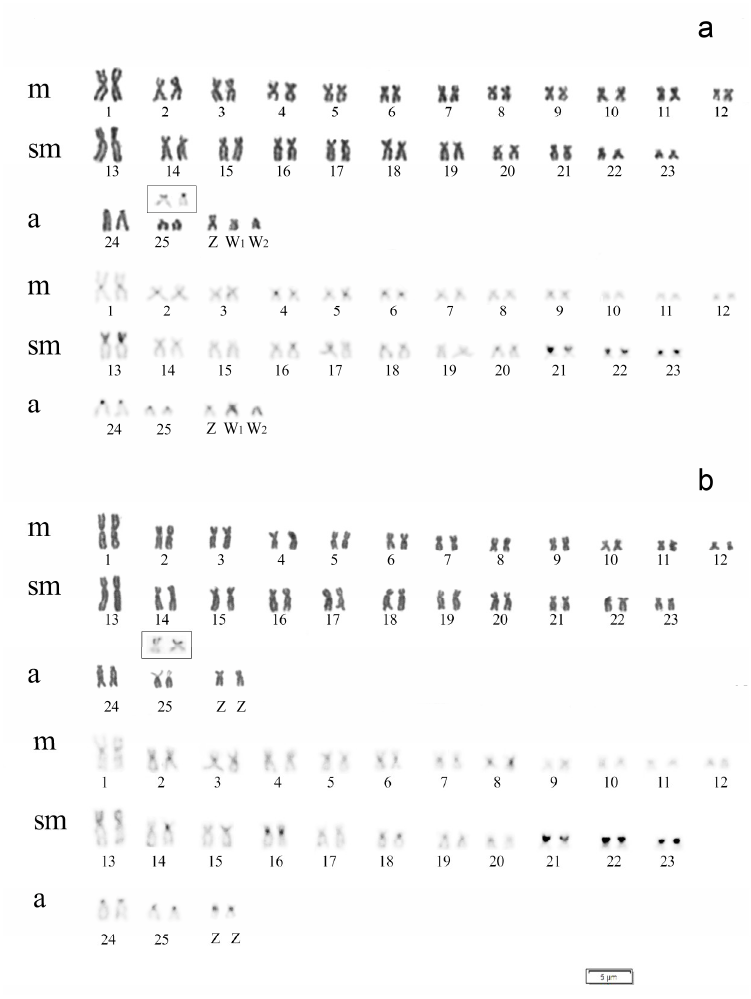
Figure 2. Male ( a ) and female ( b ) A. clementinae karyotypes arranged after Giemsa (above) and C-banding (below) staining. The chromosome pair showing Ag-NOR, after silver staining, is shown in the inset. The differences observed in both karyotypes support the occurrence of a multiple ZZ/ZW 1 W 2 -sex chromosome system, with females being the heterogametic sex.